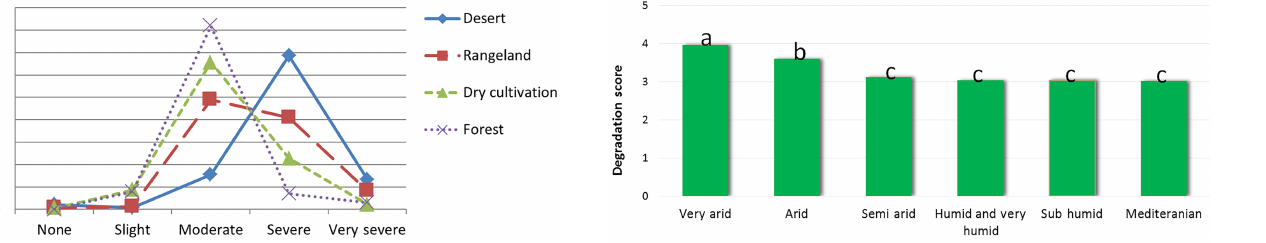
Figure 8. Average of degradation amount in the different climate types using the Duncan test: a, b and c show difference among class means at a significant level of